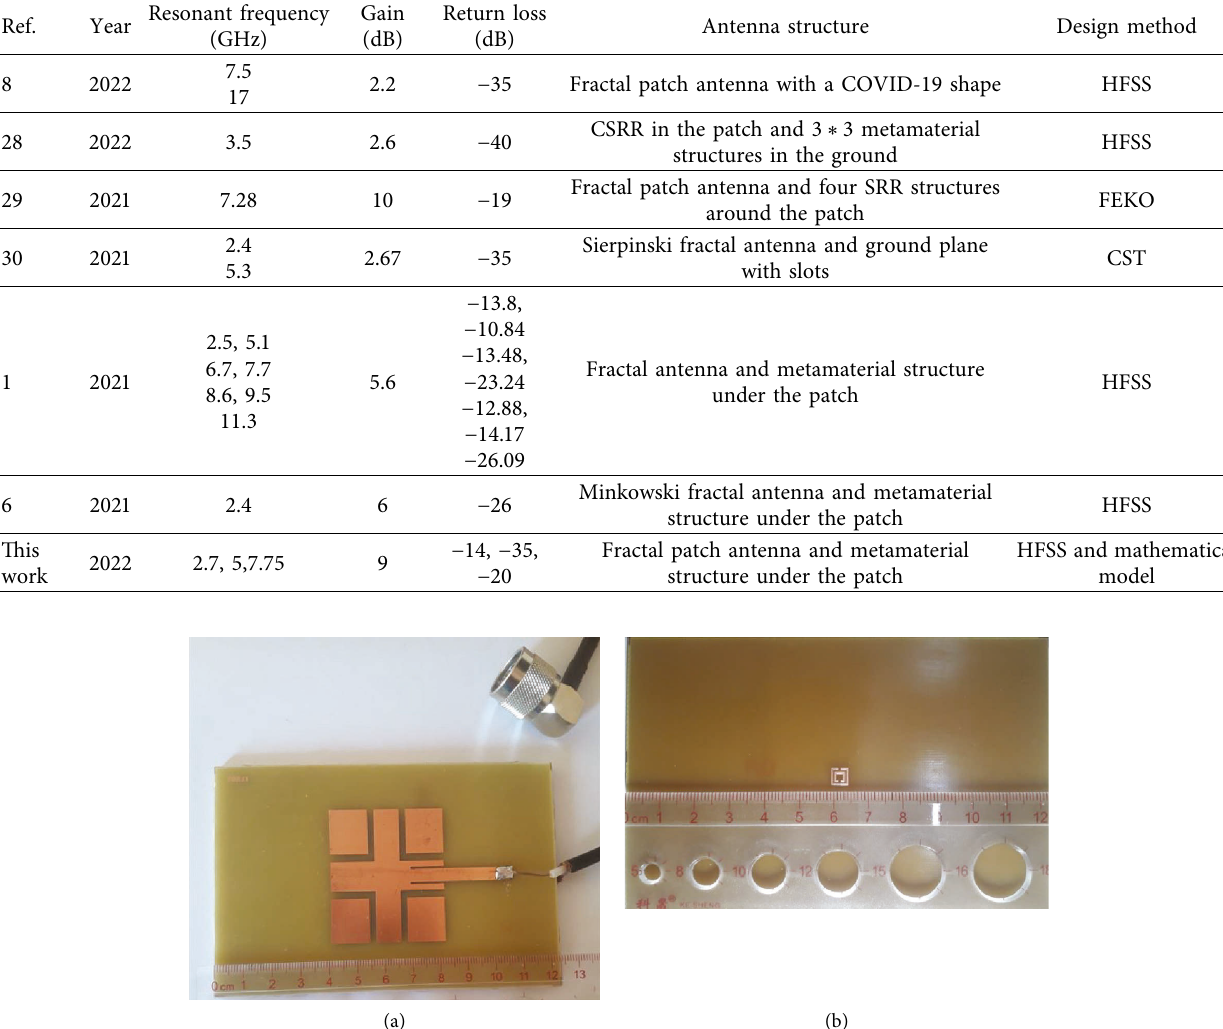
Table 3: Comparing the results of this research with a number of recent reference studies. Ref.